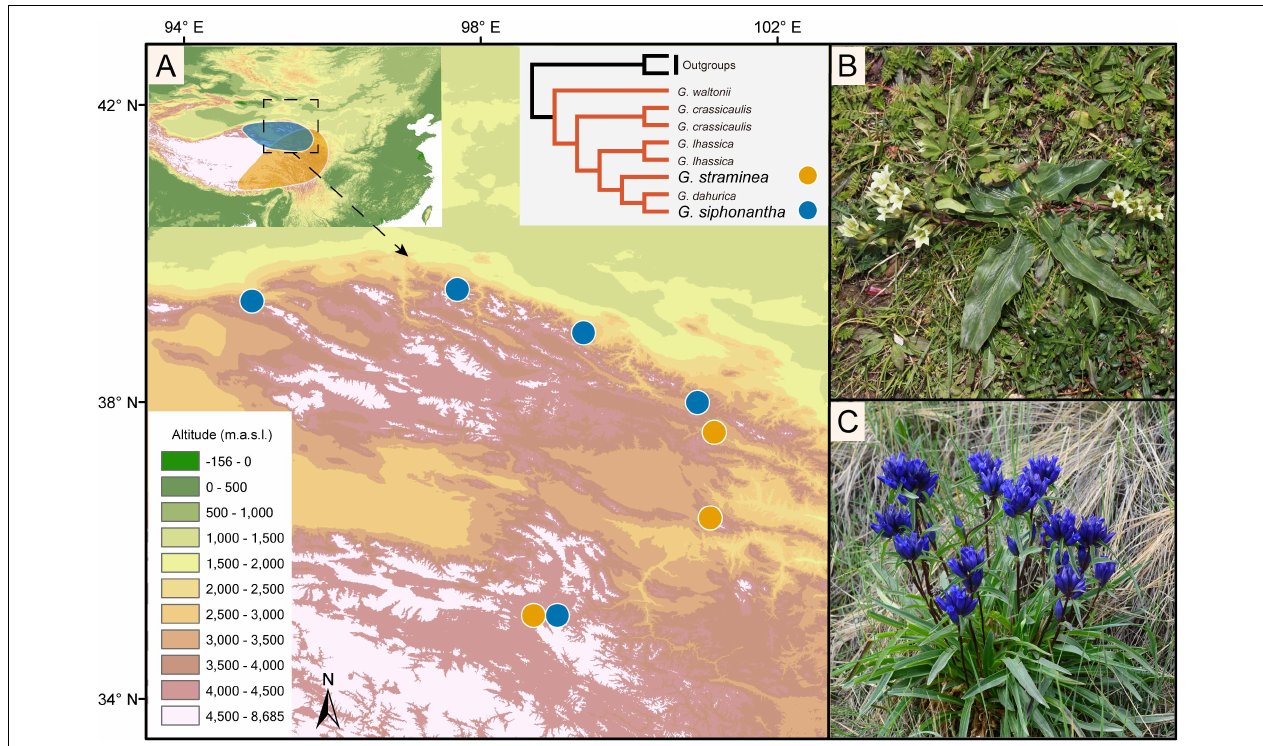
FIGURE 1 | Map showing the geographic distribution of Gentiana siphonantha and G. straminea populations collected and the photos of the two species. (A) The distribution of G. siphonantha and G. straminea . Map on top left shows the natural distribution of the two species (shadowed areas). Species tree on top right shows the phylogenetic position of the two species from Chen et al. (2020); (B) G. straminea ; (C) G. straminea